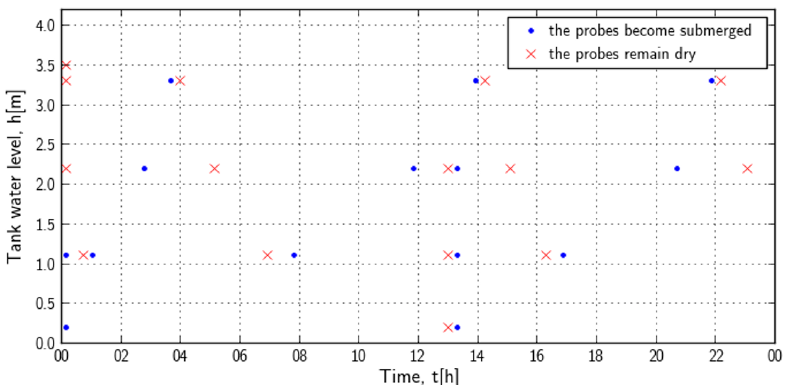
Figure 13. The diagram of the water level change h(t) in the Knez Selo water tank on 30 December 2009.